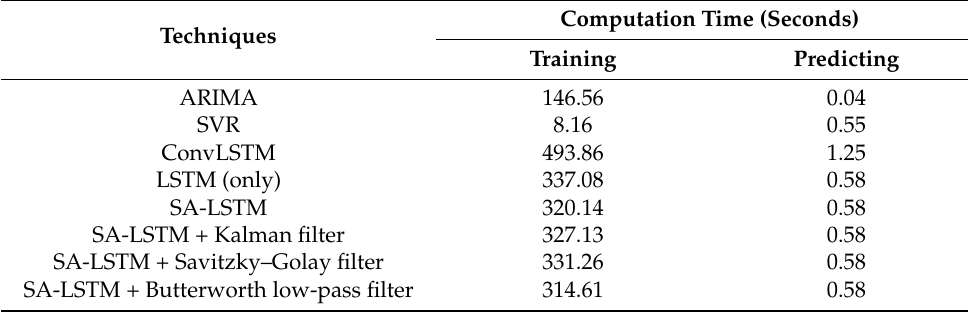
Table 7. Computation times of each technique in our